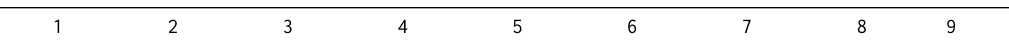
Table 1. Bivariate correlations between composite indexes of latent variables